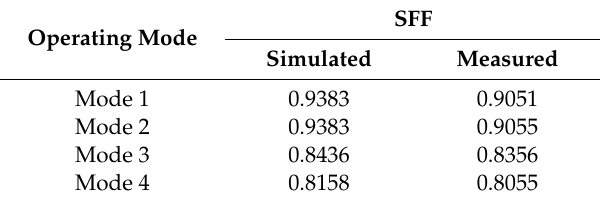
Table 5. System fidelity factor for the proposed antenna at each mode.